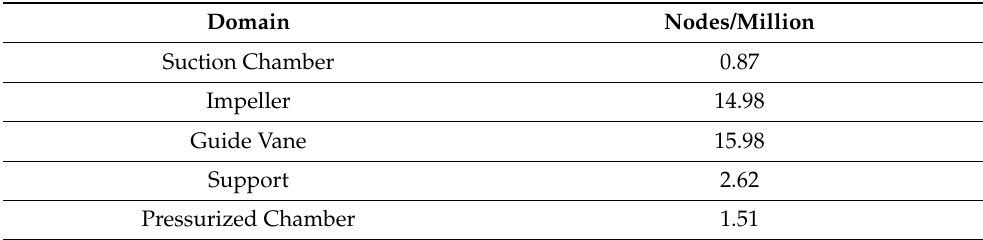
Figure 6. Flow domains and grids. The commercial computational fluid dynamics code ANSYS ‐ CFX 20.1 was used to simulate the three ‐ dimensional flow in the pump. The fluid medium was set as liquid water with a density of 998.2 kg/m 3 and a dynamic viscosity of 0.000889 Pa  s. The impeller was set as a rotating domain and the others were stationary. The simulation was per ‐ formed with the moving reference frame model. The relative pressure and the turbulent intensity of the inlet boundary were set as 1 atm and 5%, respectively. The mass flow rate (350 kg/s) was applied for the inlet boundary condition at the suction chamber inflow. A pressure outlet type boundary was set at the pressurized chamber outflow, and all the solid walls were set as no ‐ slip wall boundaries. The length of the suction chamber was 8 R t , and it was 6 R t long from the end of the diffusion section to the outlet. General grids